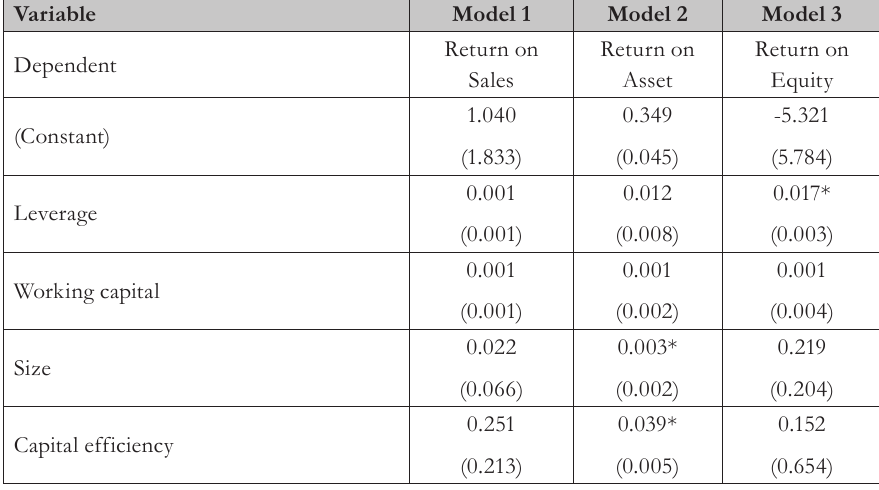
Tab. 2 - Regression results. Source: Own